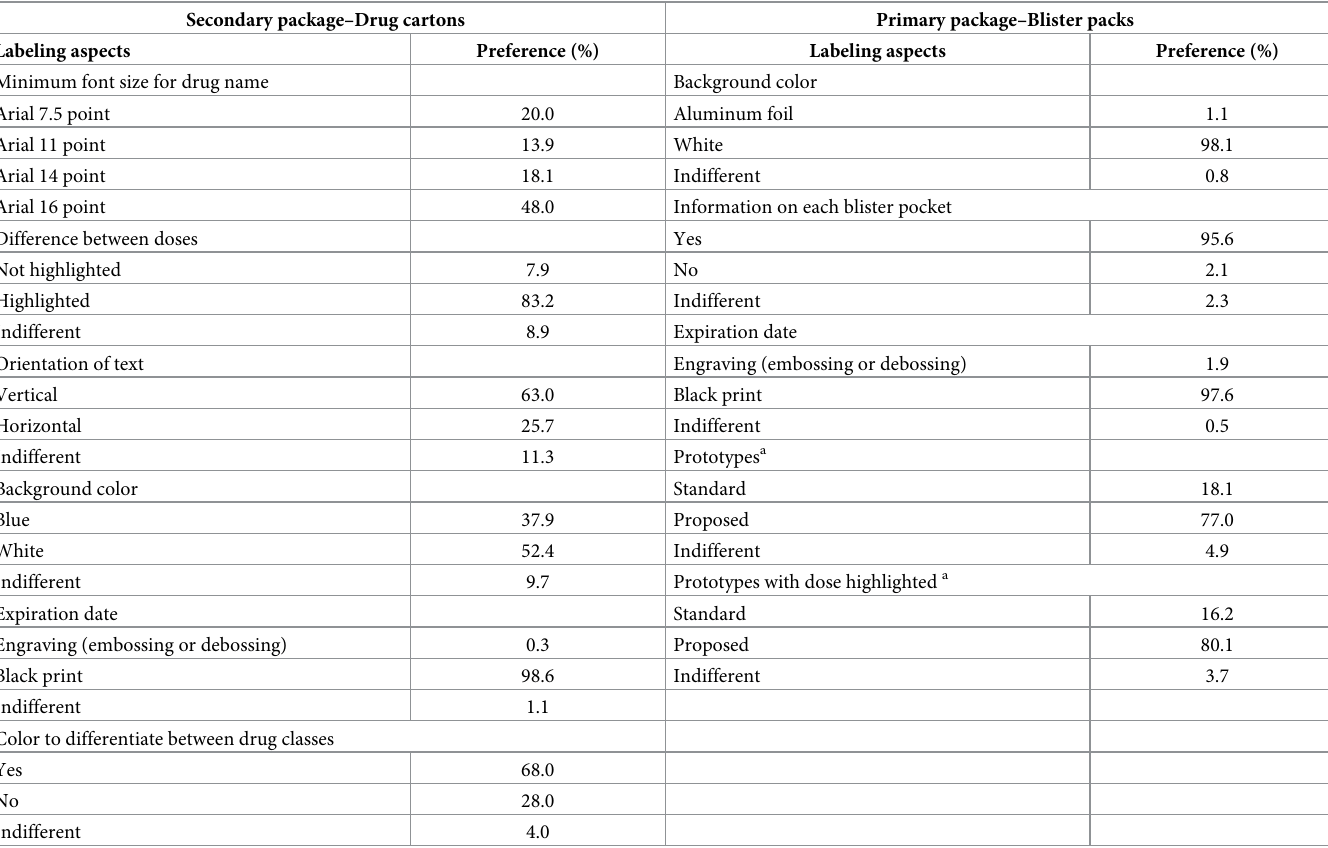
Table 3. Medication users’ labeling preferences obtained through the evaluation of simulated packages. (n = 6,225 a